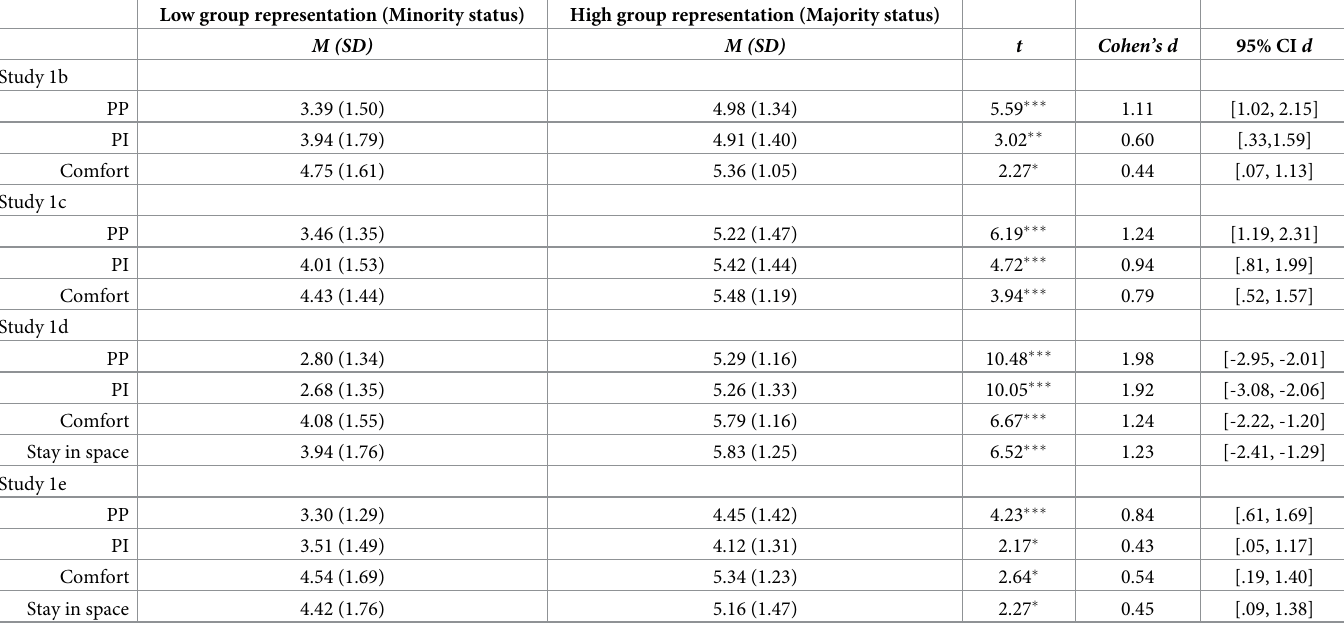
Table 2. Tests for the effect of group representation on place-prototypicality, place-identification, and outcome variables (Studies 1b-1e). Low group representation (Minority